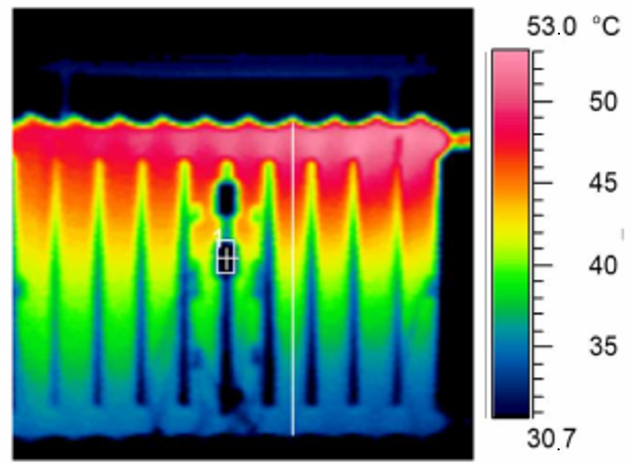
Figure 3. An example of a temperature distribution on the surface of heater T1 according to thermog- raphy measurements—measurement 2.